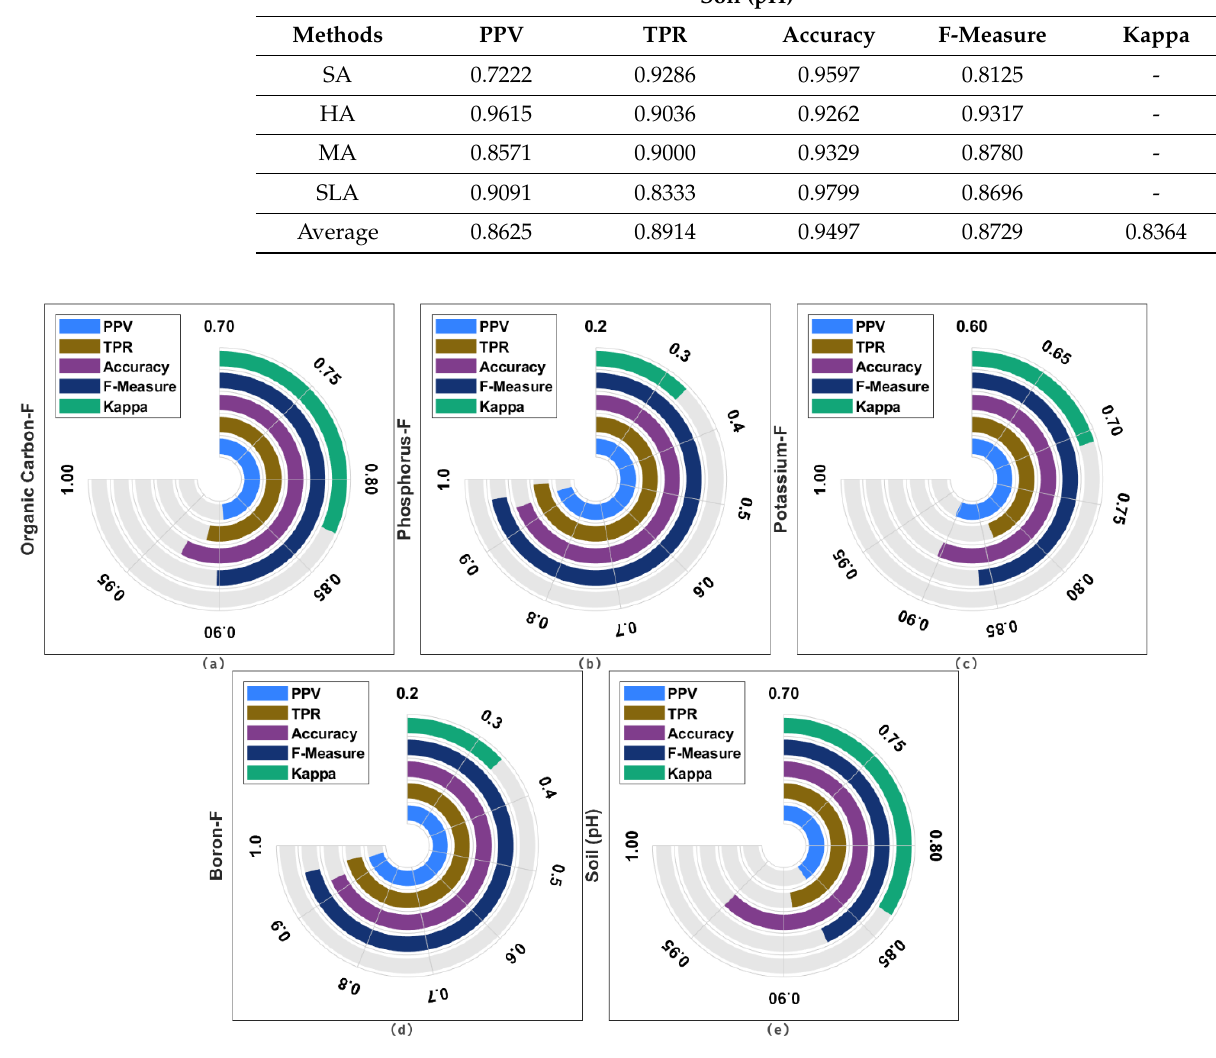
Table 3. Comparative results analysis of the ISNpHC-WVE with existing techniques [10].